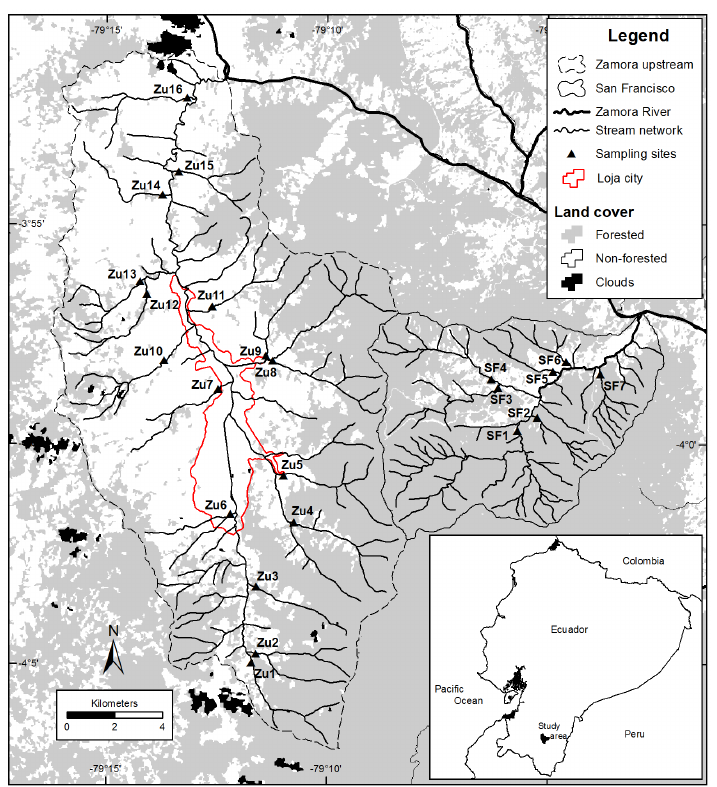
Figure 1. Study area and location of the sampling sites. Codes represent the sampling sites in the Zamora upstream (Zu1 to Zu16) and San Francisco (SF1 to SF7) catchments. Native vegetation cover was classified into forested and non-forested. Only the complete stream network for the study area is shown. Catchment characteristics are further shown in Table S1.